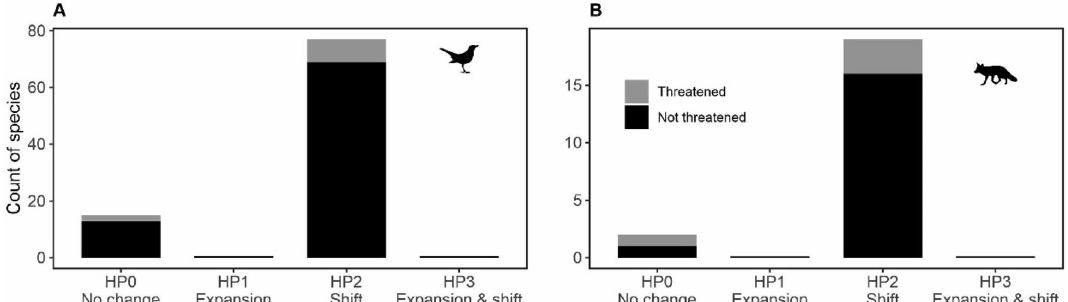
Figure 2. The number of bird ( A ) and mammal ( B ) species that fit each of the hypotheses as presented in Fig. 1. HP0 represents no expansion in the volume of the niche and no shift in habitat, HP1 represents only expansion in the volume, HP2 only shift in habitat, and HP3 represents both expansion in the volume of the niche and shift in habitat. A threshold of 0.20 (20%) was used to separate the continuous differentiation in the ecological niche, either volume or habitat shift, so that values < 0.20 represent no change for the specific niche metric, and values > 0.20 represent change. The number of threatened and non-threatened species is shown with different colors, and both sum to the total count of each bar. No species fitted HP1 nor HP3 in neither birds nor